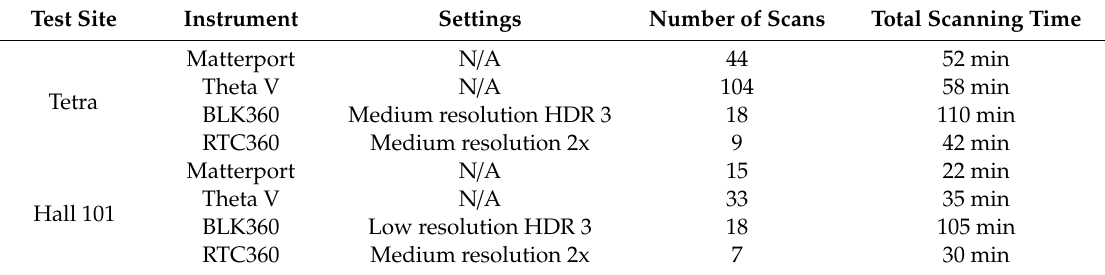
Table 2. Overview of the scanning process for the two test